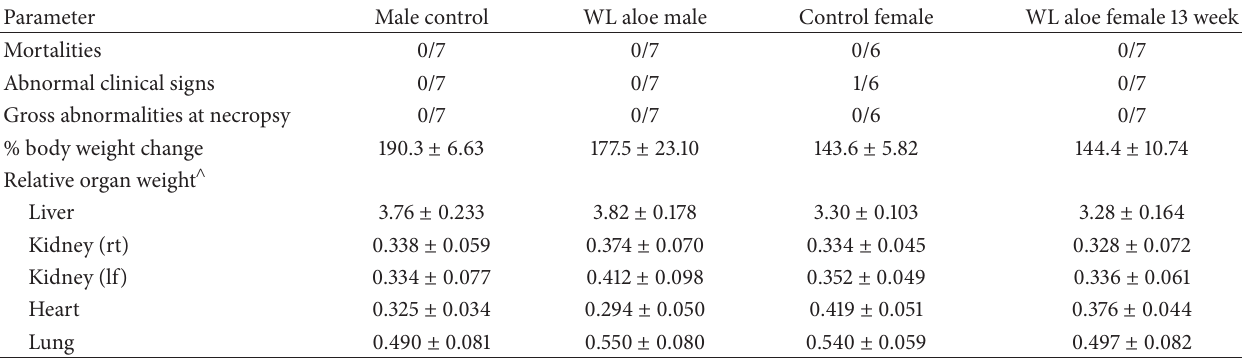
Table 5: The effect of aloe vera administration for 13 weeks on rat organ weights.